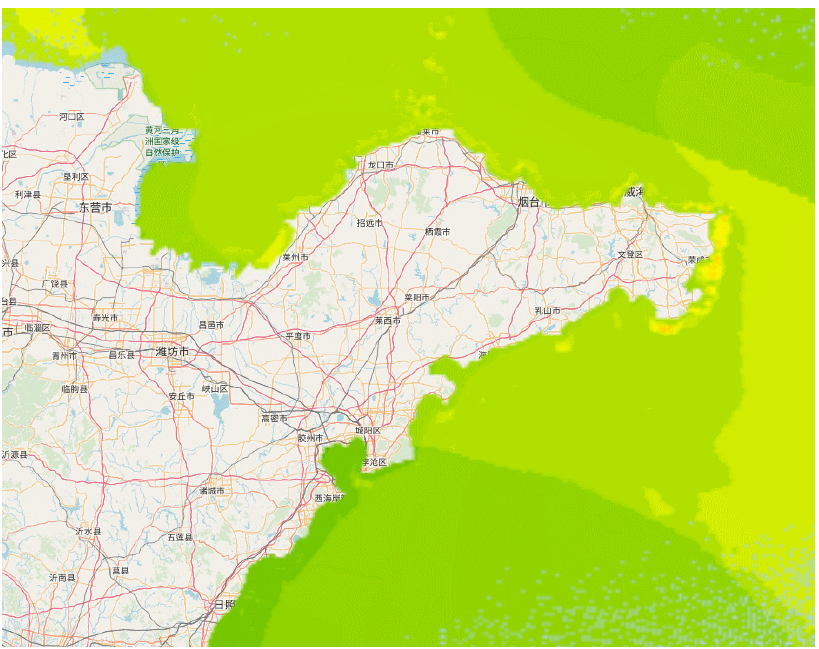
Figure 9 . Comprehensive assessment result considering risk assessment and vulnerability assess-